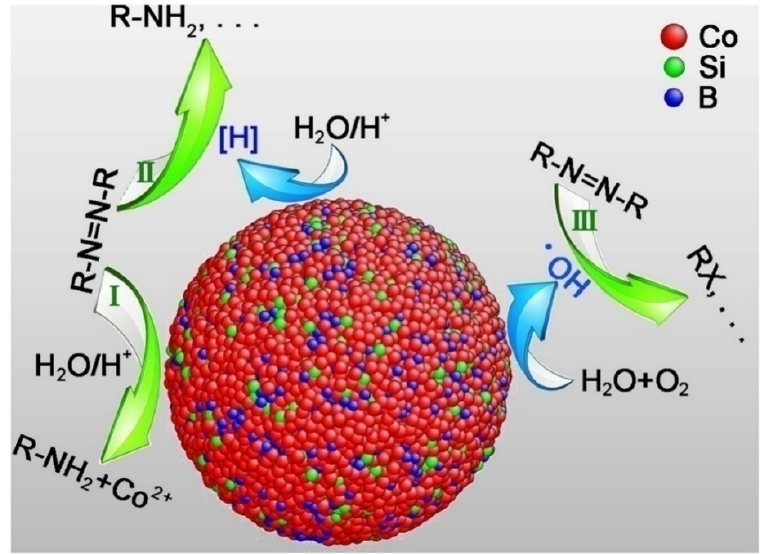
Figure 3. Illustration drawn by Qin et al. of the major reactions occurring in the amorphous alloys and the degradation mechanisms [66]. Table 2. Azo dye degradation with amorphous